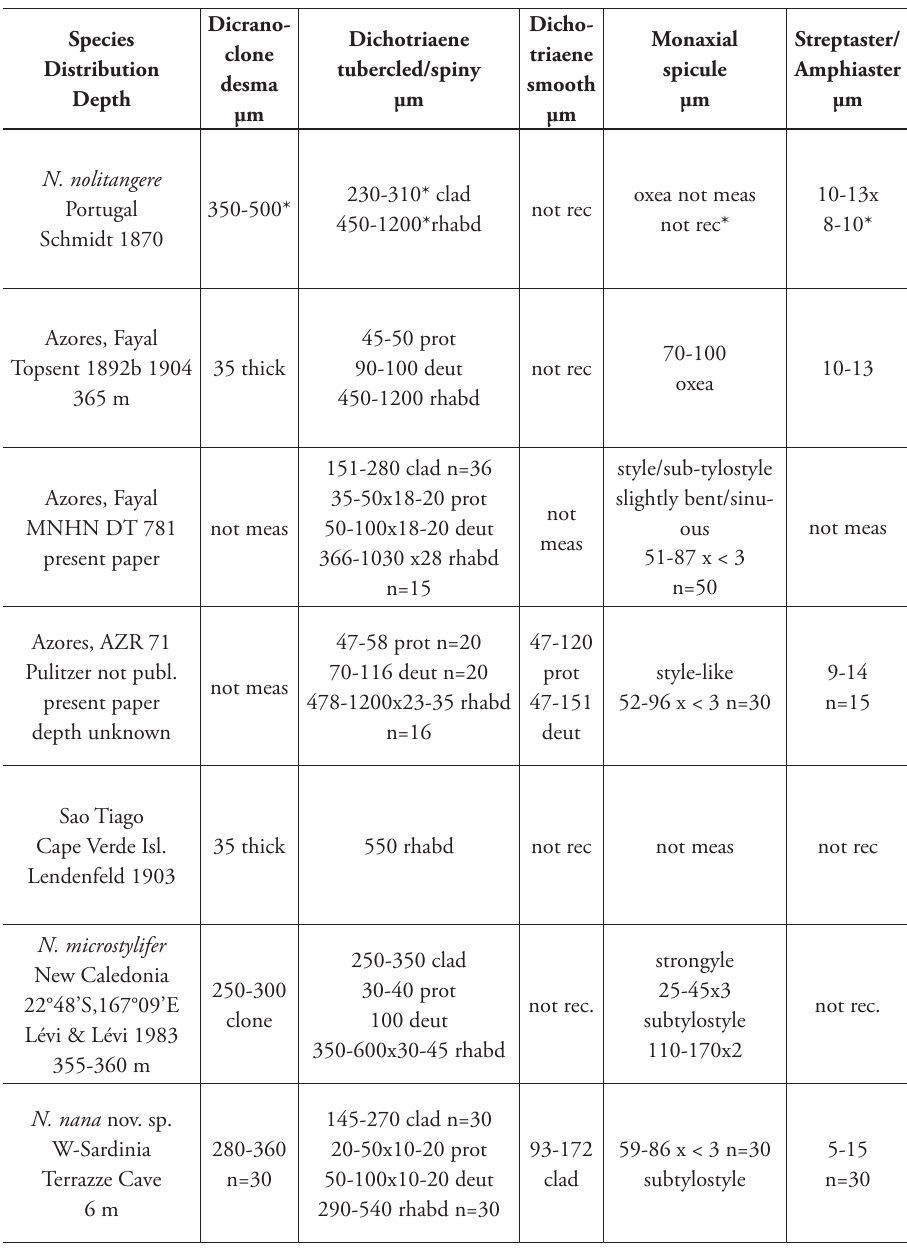
Tab. 1. Distribution, bathymetric range and spicule measurements (length x width) of the species belong- ing to the genus